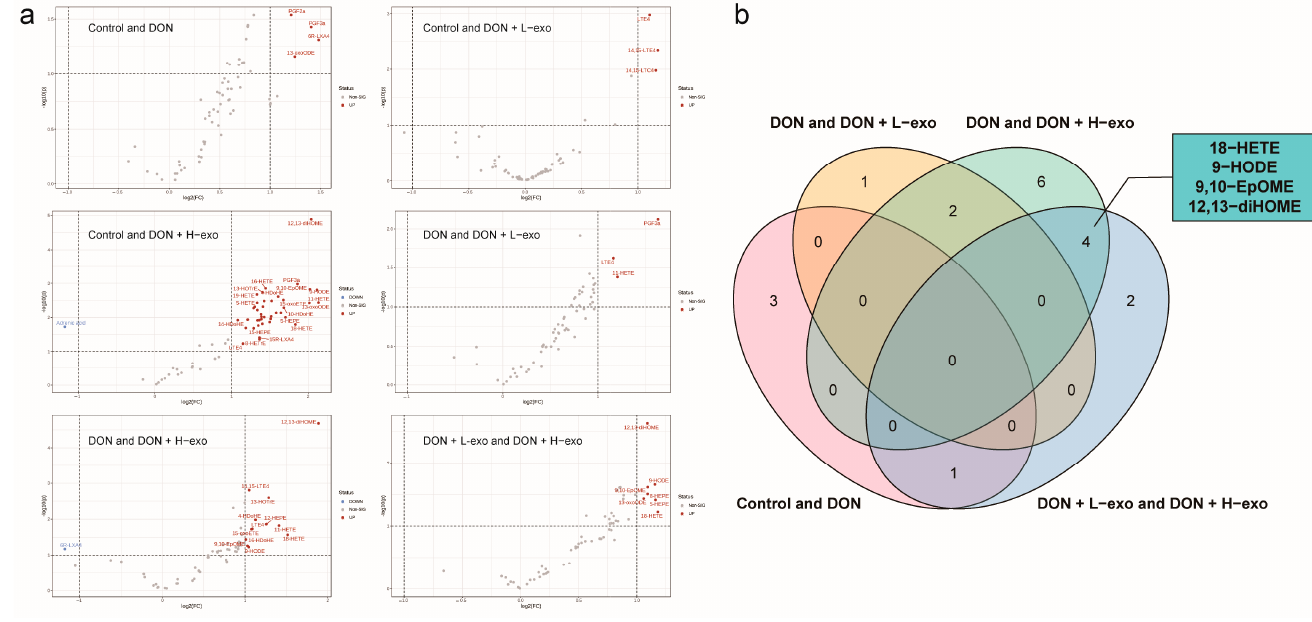
Figure 7. Screening of differential oxylipins with critical roles. ( a ) Volcano plot analysis to screen for significantly different metabolites between different groups. Red circles indicate significantly up-regulated differential metabolites and blue circles indicate significantly down-regulated differential metabolites. The fold change is log-transformed, and the farther it is from the coordinate origin (0, 0), the more significant the feature is. ( b ) Venn diagram for further the screening of differential oxylipins with critical roles.